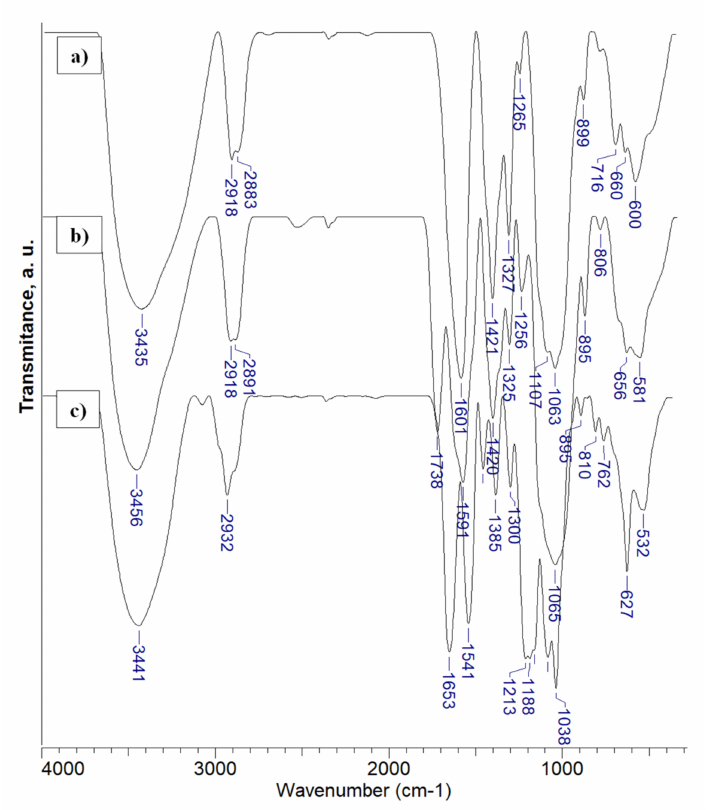
Figure 3. FTIR spectra of CS entrapped into the CMC cryogel (pre-2PEC.b, spectrum ( a ), 2PEC.b (spectrum ( b ), and PEC sample formed with PAMPS (3PEC.c, spectrum ( c ); the sample code is that allocated to the polyanion/CS sets in Table